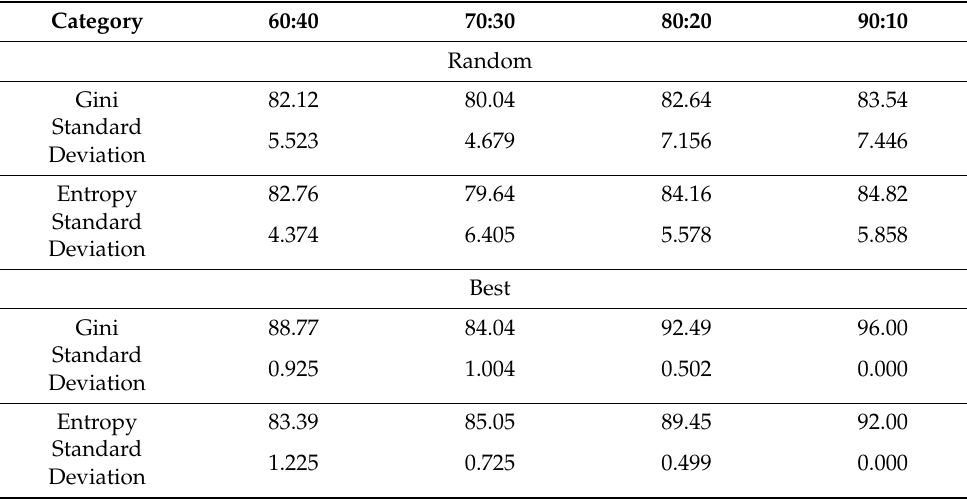
Table 5. Random Forest Classifier Summarized